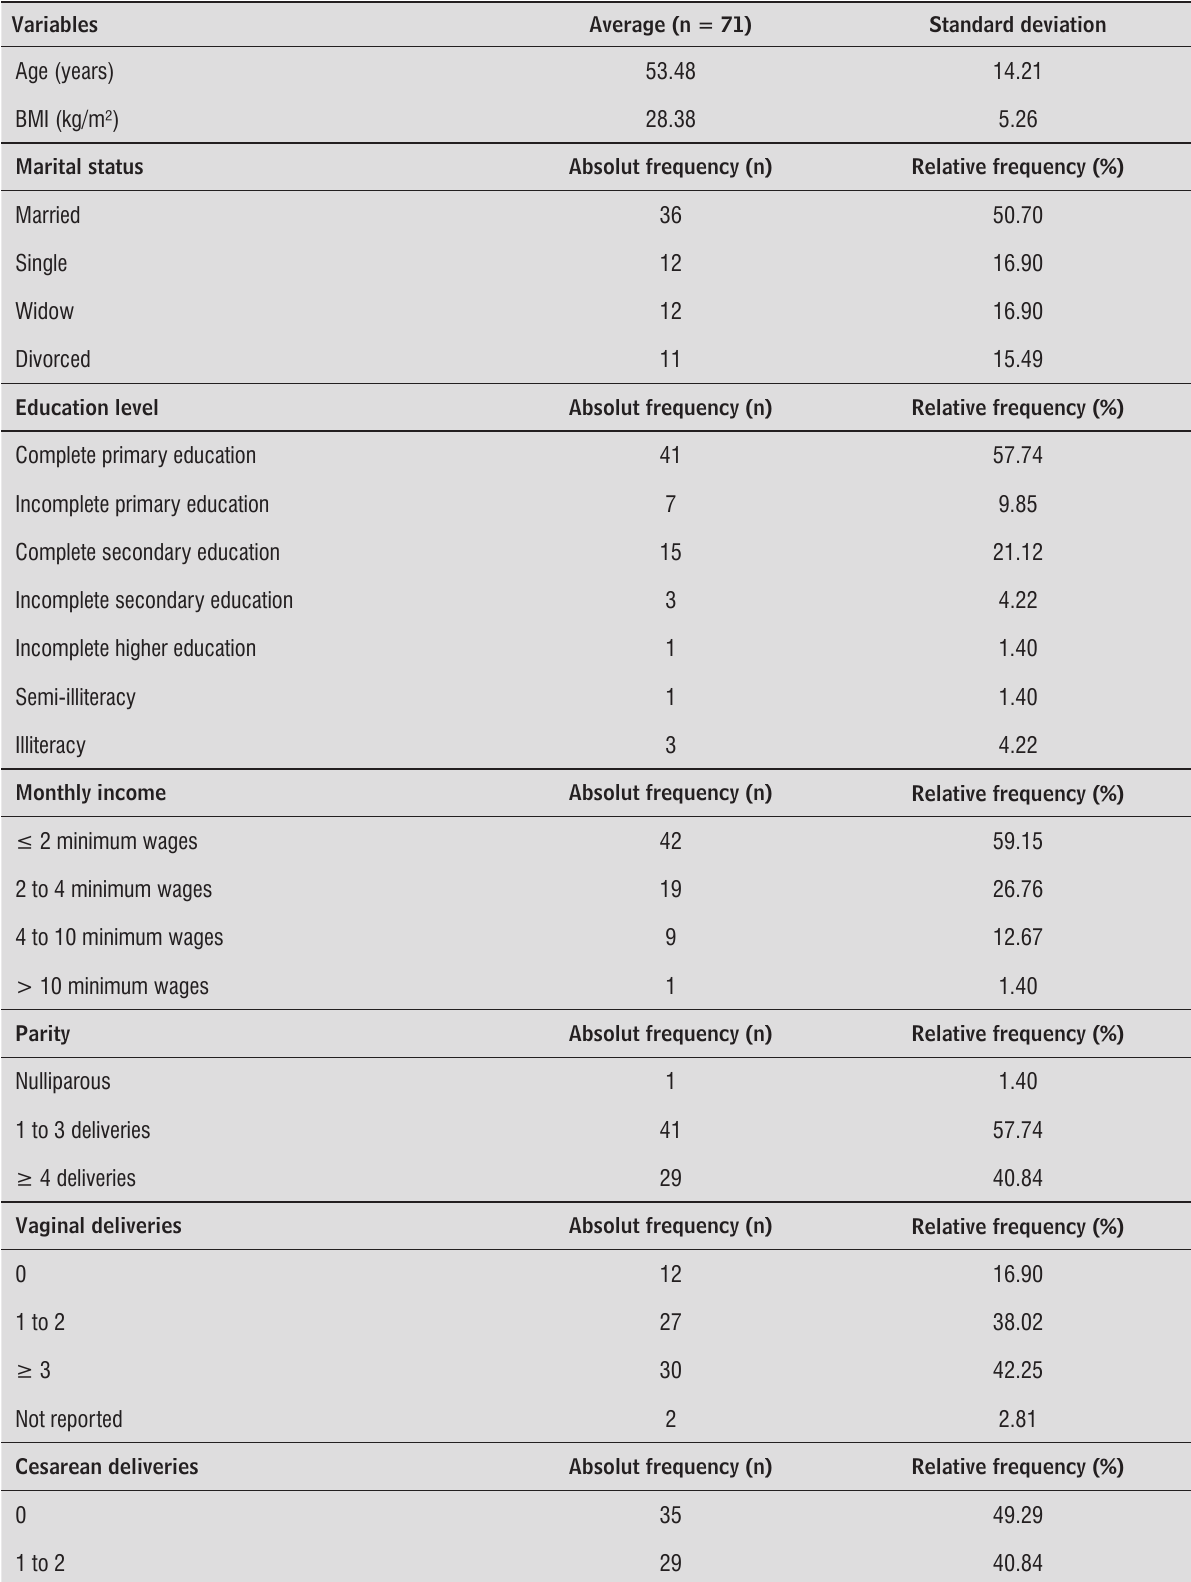
Table 1 - Socio-demographic and obstetric characteristics of women with